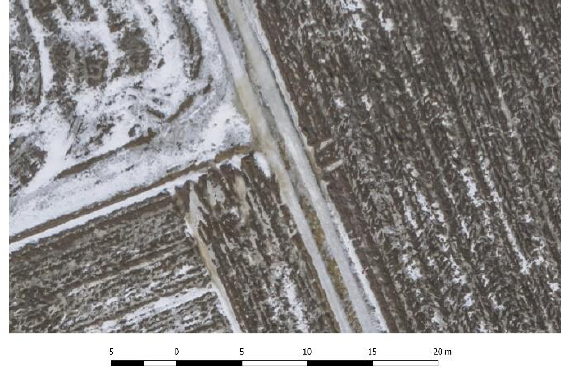
Figure 6. Crop of an image taken at 120 m AGL with the modified RGB camera